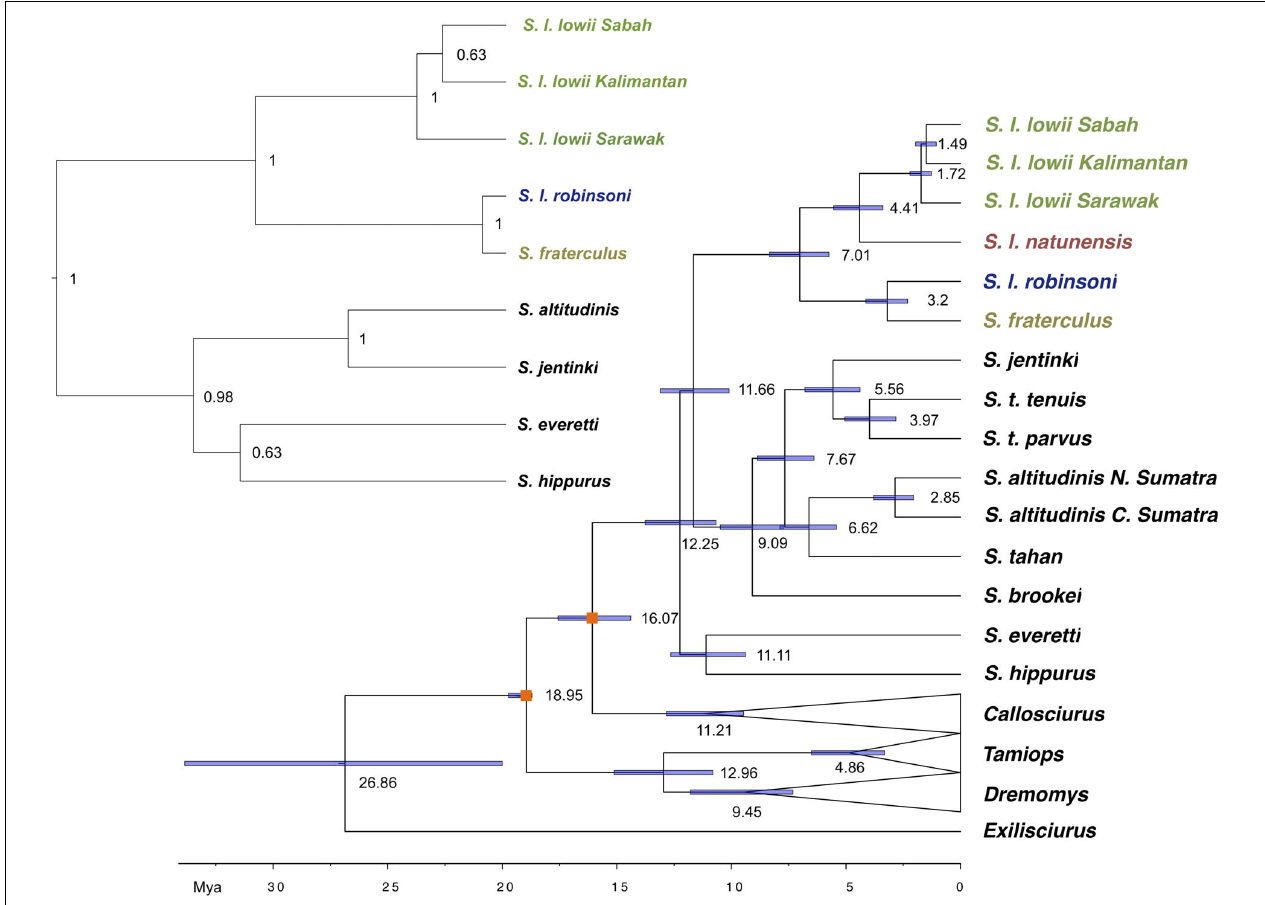
FIGURE 3 | Mitochondrial genome Bayesian maximum clade credibility tree including all Sundasciurus species from Sundaland. Dates are indicated on the bar at the bottom of the figure in millions of years before present (Mya) and on nodes. Nodes used to calibrate the dating are marked with an orange box. All nodes are fully supported (PP = 1). Inset shows a species tree of the Low’s and Fraternal squirrel species complex, as estimated from nine nuclear loci using *BEAST. Ingroup samples of the four main clades are colored to match Figure 1 map. Outgroup samples are shown in black. Outgroup genera clades are collapsed for